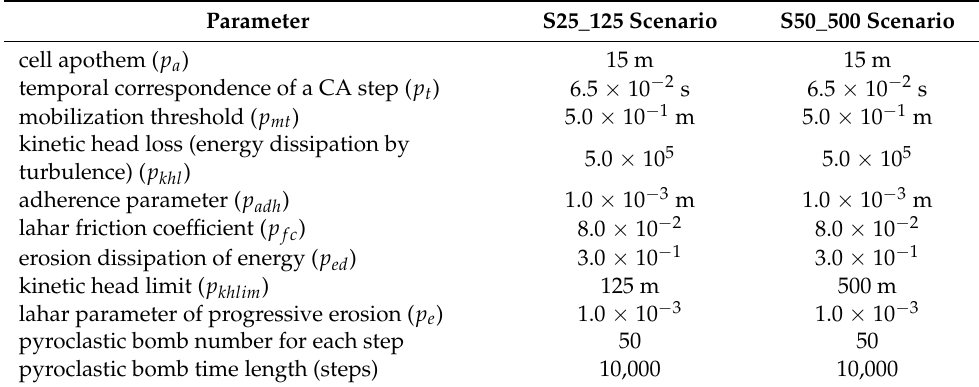
Table 3. Parameters of LLUNPIY-PB